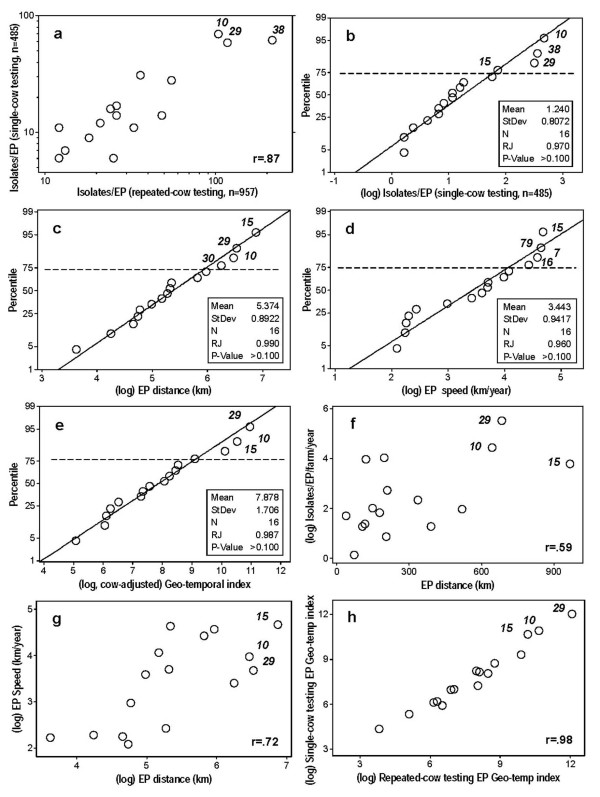
Non-spatial and composite (non-spatial and spatial) microbial diffusion. The number of EP-specific interfarm isolates correlated significantly between repeated and single testing of the same animals (r = .87, P < 0.01, as indicated in Table 4, columns B and D, a). Four indices that estimate bacterial diffusion are described: the (single-cow testing based) number of isolates/EP (as indicated in Table 4, column E, b), the distance assumed each EP disseminated over time (EP distance, as indicated in Table 2, column C, c); the EP diffusion velocity (EPspeed, as indicated in Table 2, column E, d); and the product of (fully adjusted) interfarm isolates/EP and EP speed (the fully adjusted geo-temporal or EPGeotemp index, as indicated in Table 4, column N, e). Diagonal lines indicate the expected distribution under the hypothesis of linearity. The null hypothesis of lack of normality was rejected (Ryan-Joiner [RJ] test > 0.05). Significant correlations were observed (i) between the isolates/EP index (adjusted for single-cow testing, number of farms, and time) and EPdist (r = .59, P < 0.02, as indicated in Table 4, columns J and L, f), (ii) between EPdist and EPspeed (r = .72, P < 0.01, as indicated in Table 2, columns C and E, g), and (iii) between both versions of the EPGeotemp index (non-repeated vs. repeated testing of the same cow, r = .98, P = 0.01, as indicated in Table 4, columns M and N, h). Numbers in italics identify EPs above the 75th percentile or displaying the highest values.